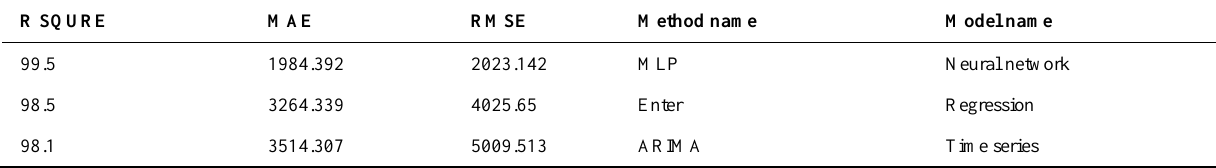
Table 15. The comparison between techniques using factors in this